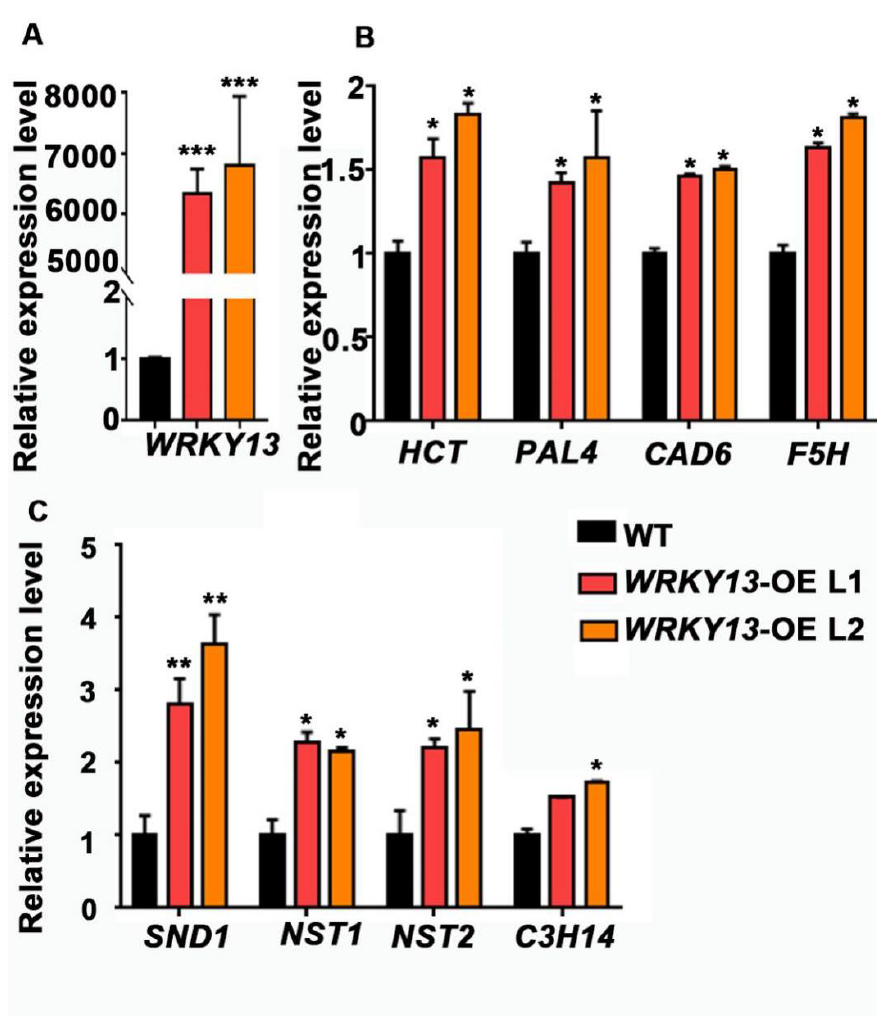
Figure 6. Lignin biosynthetic genes and secondary wall-related genes are altered in PtoWRKY13 -OE lines. ( A ) Expression levels of PtoWRKY13 in WT and PtoWRKY13 -OE seedlings. ( B ) Expression levels of lignin pathway genes HCT (AT5G48930), PAL4 (AT3G10340) , CAD 6 (AT4G37070), and F5H (AT4G36220) in WT and transgenic A. thaliana . ( C ) Expression levels of secondary wall-related key transcription factors SND1 (AT1G32770), NST1 (AT2G46770), NST2 (AT3G61910), and C3H14 (AT1G66810) in WT and transgenic A. thaliana . Actin7 was used as an internal reference gene. Error bars represent the standard error (S.E.) of three independent biological replicates. Asterisks indicate a significant difference with respect to WT plants using the Student’s t -test (*, p < 0.05; **, p < 0.01; ***, p < 0.001).